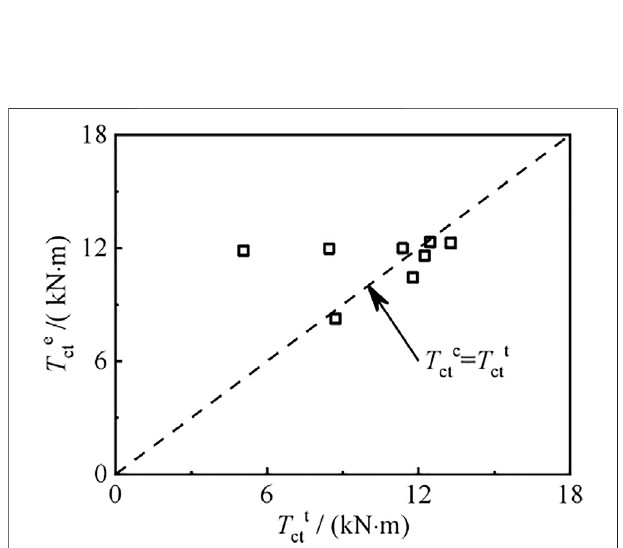
FIGURE25| f cu effectonthe T – θ curveofthecompressiontorsionmember.